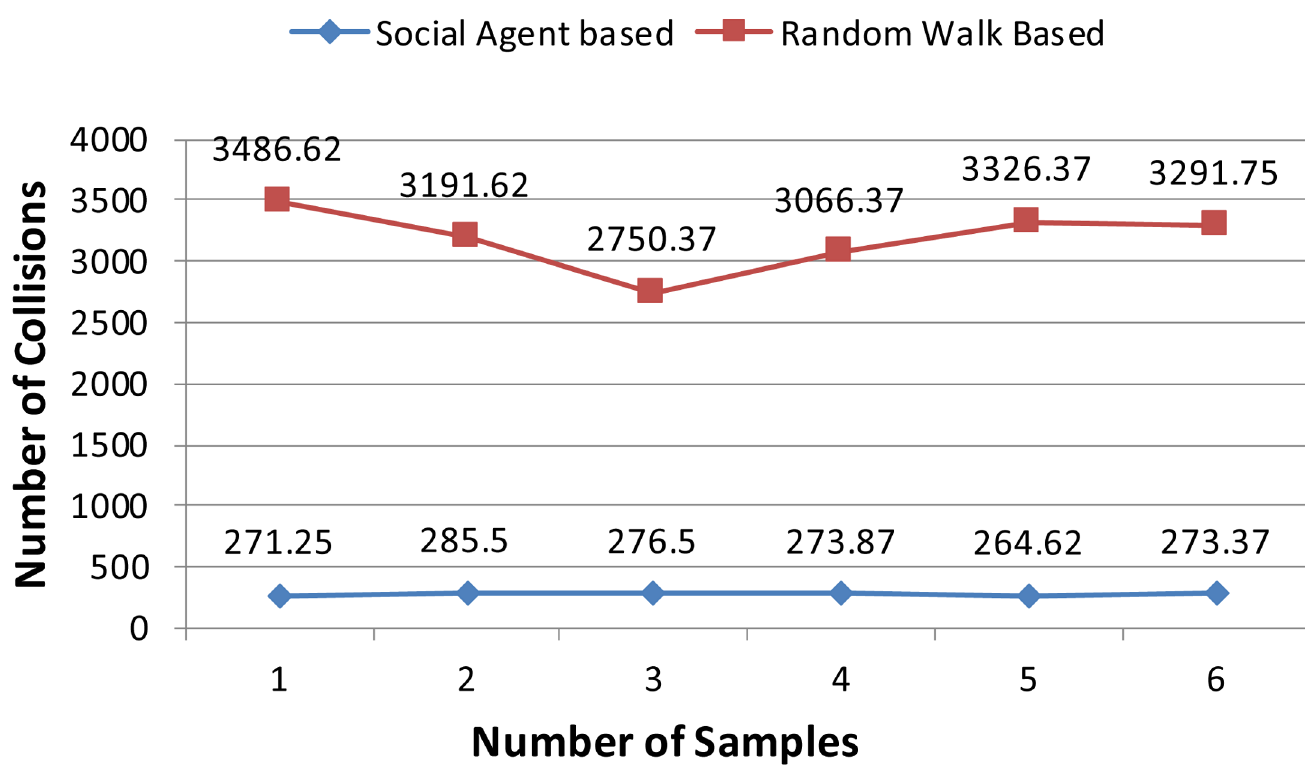
Fig 5. Graphical representation of test case 2. https://doi.org/10.1371/journal.pone.0186103.g005 PLOS ONE | https://doi.org/10.1371/journal.pone.0186103 October 17,